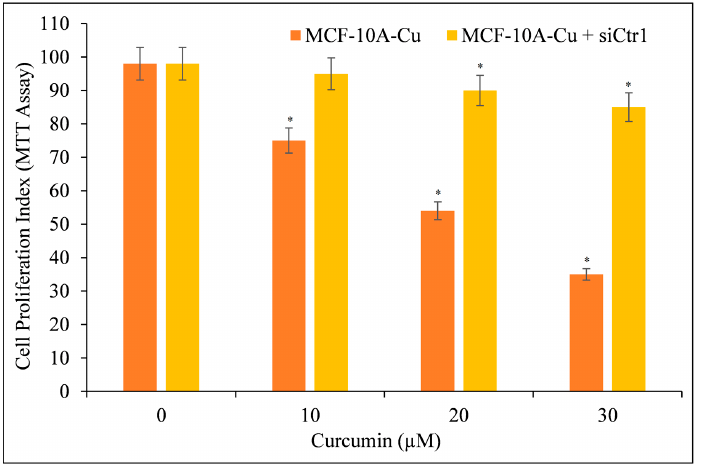
Figure 11. Cell proliferation of MCF ‐ 10A+Cu cells (normal MCF ‐ 10A cells cultured in a medium containing 25 μ M CuCl 2 ) was significantly reduced after treatment with curcumin following CTR1 knock ‐ down. MCF ‐ 10A+Cu cells were first treated with curcumin or with specific siRNA against CTR1 (siCtr1) for 48 h and then with indicated concentrations of curcumin for 24 h. Values reported are ±S.E.M of three independent experiments. * p value < 0.05 when compared to respective